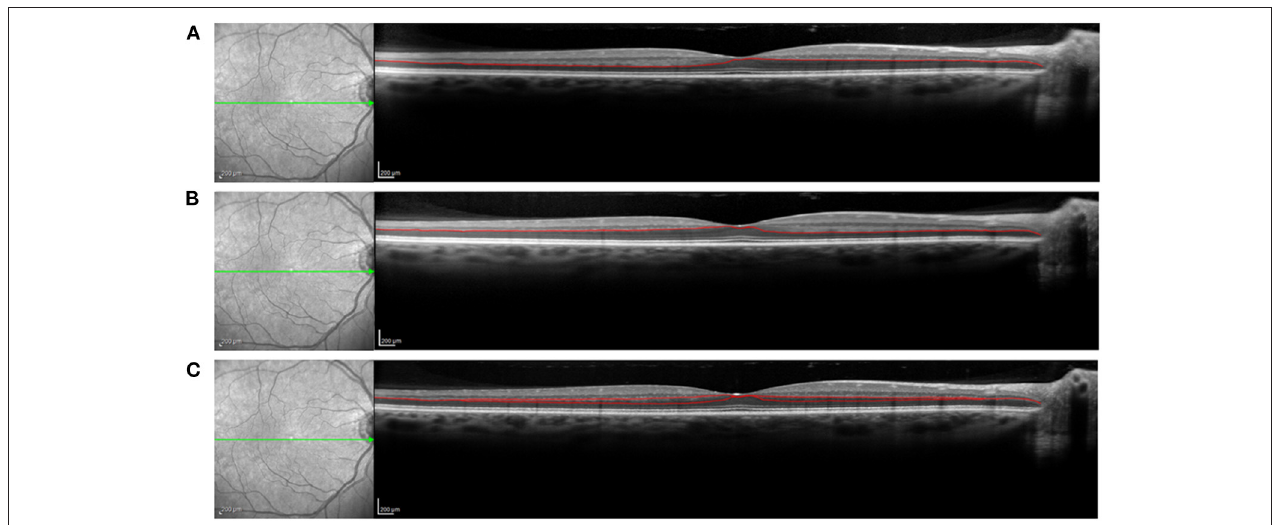
FIGURE 1 | OCT imaging of the Henle fiber layer (HFL). Offset of the entry position of the imaging beam though the pupil results in improved visualization of the HFL. The posterior border of the HFL is more clearly delineated on the distal side of the pupil offset, while the anterior border is more clearly delineated on the proximal side of the pupil offset. (A) Nasal offset of the imaging beam through the pupil, resulting in improved visualization of the posterior border of the temporal HFL and anterior border of the nasal HFL with manual segmentation line. (B) Temporal offset of the OCT imaging beam through the pupil, resulting in improved visualization of the posterior border of the nasal HFL and anterior border of the temporal HFL with manual segmentation line. (C) No offset of OCT imaging beam through the pupil, with poor delineation of the HFL. Segmentation lines from nasal and temporal offsets are included to demonstrate the HFL thickness profile along the horizontal meridian. The green arrows on the en face images represent the meridian of